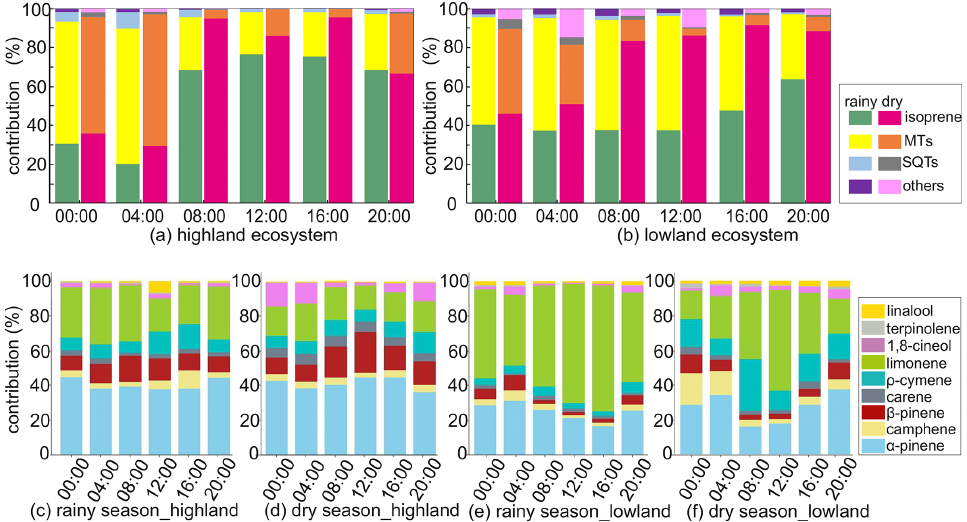
Figure 5. Diurnal contribution of biogenic volatile organic compounds (a, b) and contribution of monoterpenoids (MTs) (c, d, e, f) across the highland site and the lowland site in the rainy and the dry seasons. SQTs is sesquiterpenes, and others are 2-Methyl-3-buten-2-ol and bornyl